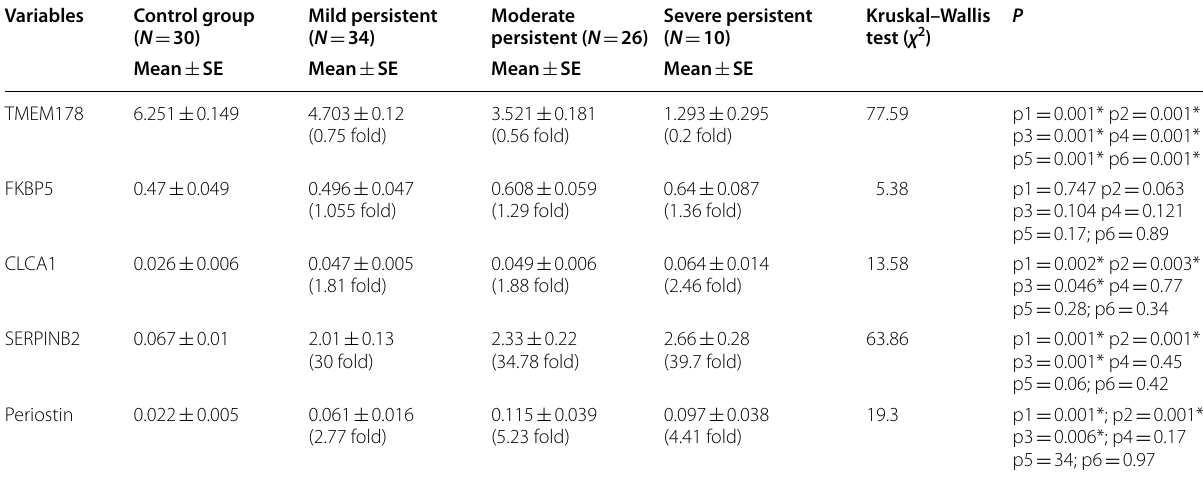
Table 3 Expression of nasal epithelial cell genes in the studied